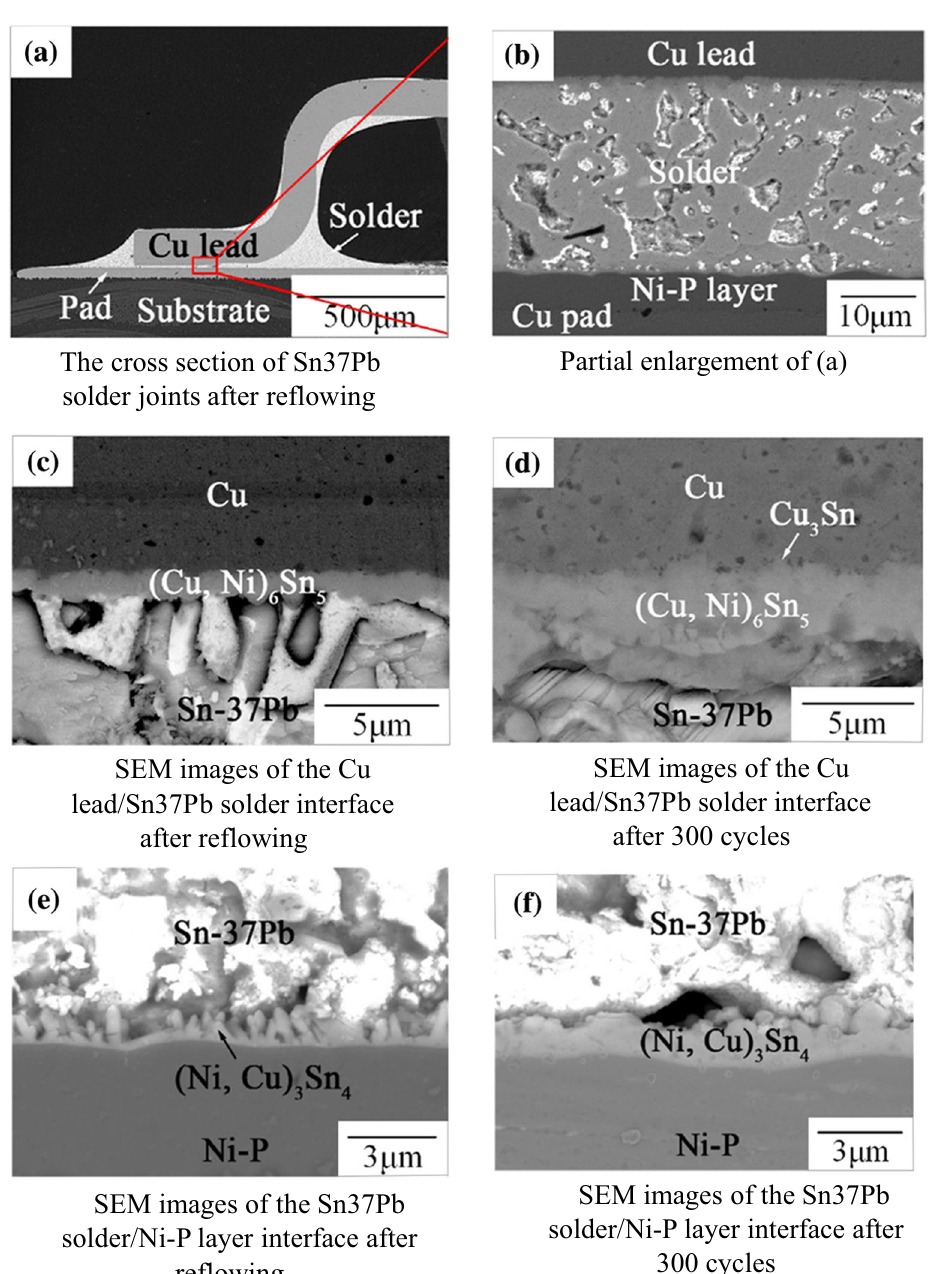
Figure 2 Microstructure and microstructure of Sn37Pb solder joints before and after 300 times thermal cycling